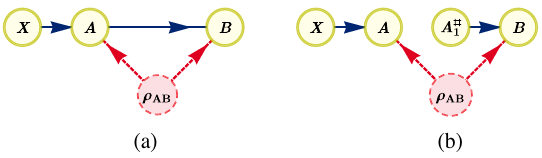
FIG. 5. (a) The instrumental causal structure and (b) its maximal interruption, which is isomorphic to the standard causal structure of a Bell experiment. Tsirelson-type inequalities pertaining to the interrupted graph are translated into constraints for the quantum instrumental scenario [35 – 37] via the postselection relation P